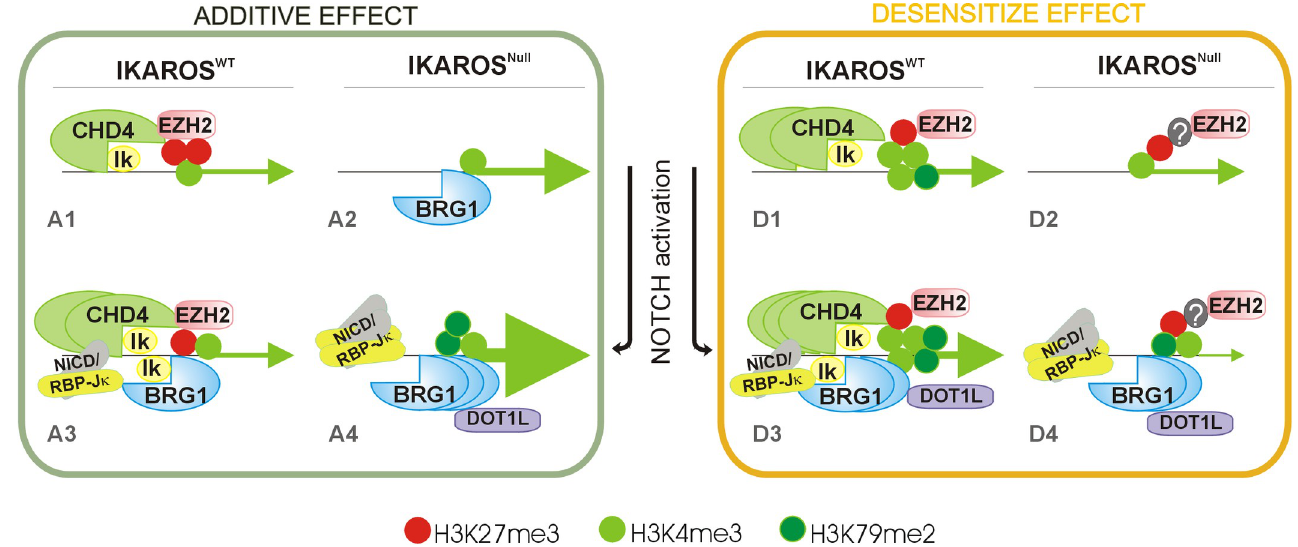
Fig 9. Proposed model of IKAROS measured response of NOTCH target genes upon NOTCH signaling in erythroid cells. This model summarizes the contribution of IKAROS in the regulation of NOTCH target genes. Two groups of genes were identified and investigated: genes overexpressed when IKAROS is absent and the NOTCH pathway is induced (‘additive effect’, left panel); and genes downregulated by the absence of IKAROS combined to the NOTCH pathway induction (‘desensitize effect’, right panel). Based on the results presented in here, IKAROS and NuRD are first and foremost required for priming and transcriptional poised chromatin organization of these genes. Both, additive as well as desensitize genes share common regulation when IKAROS is present and the NOTCH pathway is not induced (A1, D1). IKAROS then binds chromatin and establishes competence for CHD4/NuRD (CHD4) and EZH2/PRC2 (EZH2) recruitment. H3K27me3, which is produced by the methyltransferase EZH2, marks the chromatin of Cdkn1a , Prdm16 and Nrarp , but not the chromatin of the transcriptionally active Tp53 gene. Whether EZH2 is recruited or the H3K27me3 mark removed rapidly from this transcriptionally active gene, is not known. H3K4me3, which results from the activity of MLL/SETD1 methyltransferases, also characterizes the four target genes when IKAROS is present and the NOTCH pathway is not induced. Together, H3K27me3 with H3K4me3 typify bivalent chromatin associated to many primed genes and transcription poised organization. In the absence of IKAROS and/or induction of NOTCH (A2-A4 and D2-D4), the chromatin association of IKAROS and CHD4/NuRD can hinder efficient/ optimal recruitment of BRG1/BAF and restrict transcriptional enhancement; the substantial recruitment of CHD4/NuRD to chromatin requires IKAROS but can be further enhanced upon NOTCH activation (NICD might also interact with NuRD [8]); the high expression or overexpression of additive and desensitize genes is associated with increasing H3K79me2, which is deposited by DOT1L and is associated to the transcriptional elongation machinery. The regulation of additive and desensitized gene differs in the ratio between the H3K27me3 and H3K4me3 that characterizes their chromatin upon NOTCH pathway induction and/or the absence of IKAROS. In summary, the regulation of these genes is similar in IKAROS expressing cells prior to NOTCH pathway induction. After NOTCH induction, the regulation of additive genes and desensitize genes diverge. Thus, we propose that IKAROS is a pioneer transcription factor granting chromatin organisation and competence for gene expression, which are critical for rapid and physiological transcription induction upon signaling. Grey line: gene TSS (transcriptional start site); Ik: IKAROS; green arrows: active transcription, which is proportional to the size of the arrow; orange filled dot; histone H3K27me3; light green filled dot histone H3K4me3; dark green filled dot: histone H3K79me2;?: unknown additional